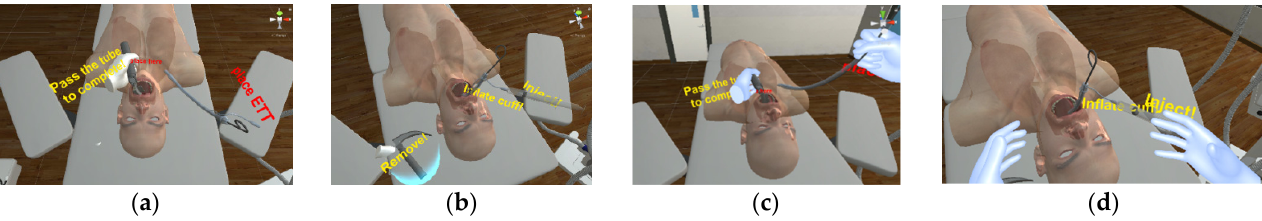
Figure 4. The scene of sniff position and ambulatory bag pressing: ( a ) text assistance; ( b ) pressing with controller; ( c ) sniff position with hand; ( d ) pressing with hand.